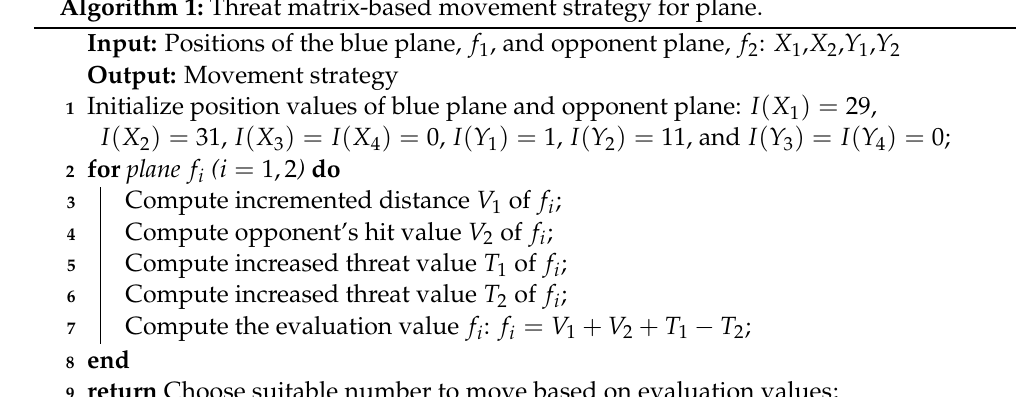
Algorithm 1: Threat matrix-based movement strategy for